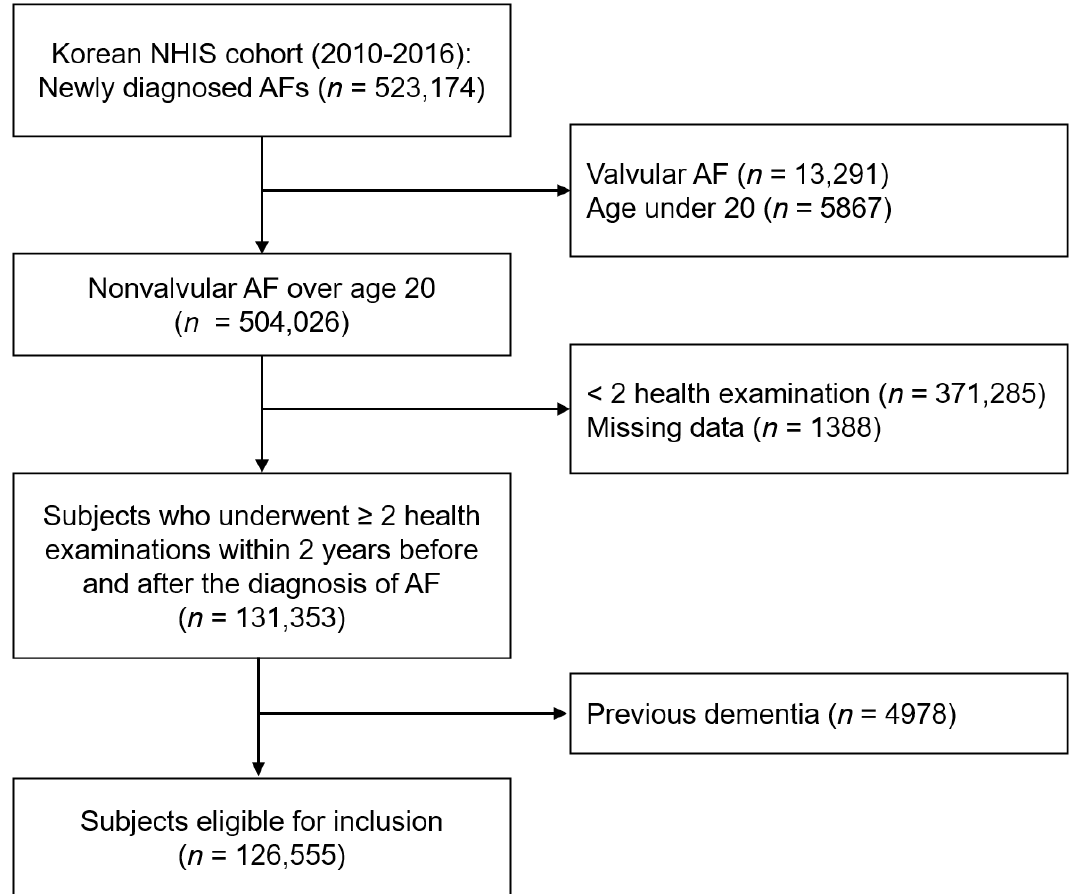
Figure 1. The flowchart of the study population enrollment. AF, atrial fibrillation; NHIS, National Health Insurance Service.